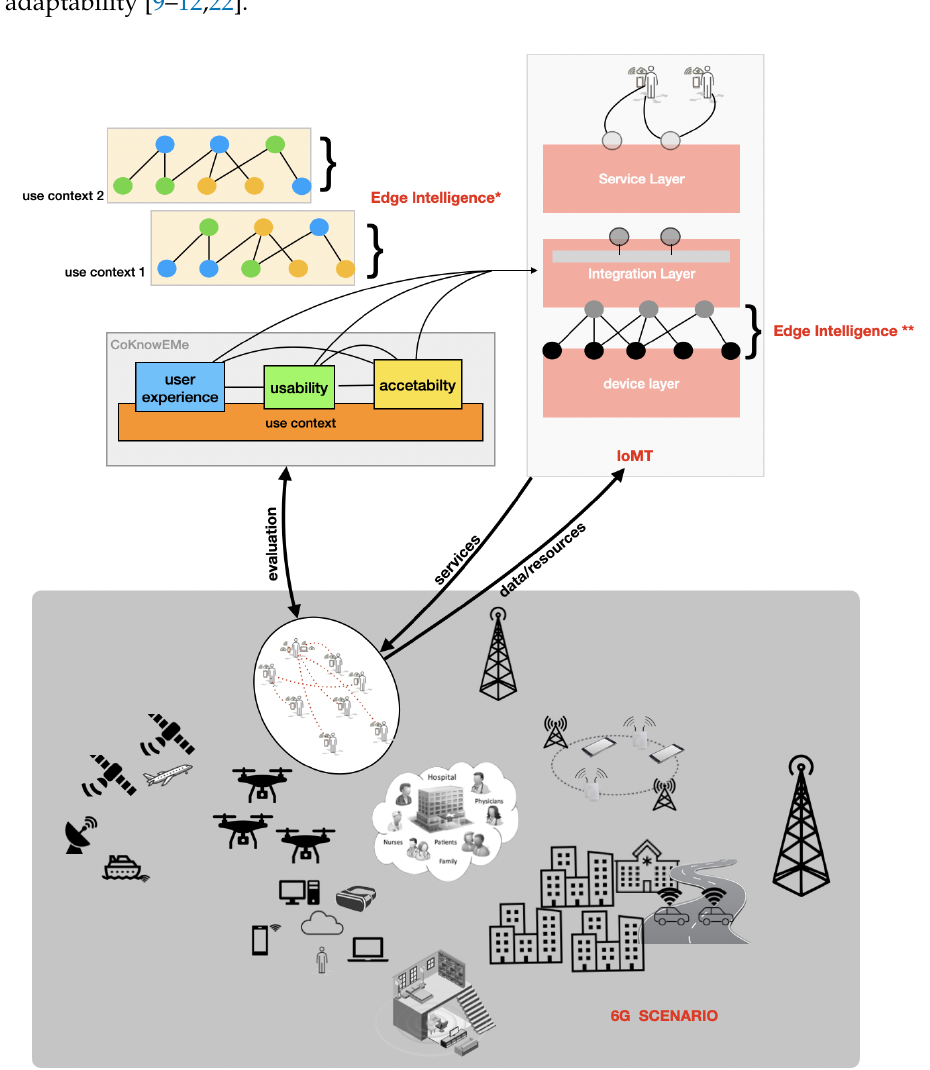
Figure 1. Evaluation in a 6G scenario for IoMT microservices. This figure shows the schematic representation of the evaluation scheme following the complex approach for IoMT services as dy- namical resources organized at the edge level in a multilevel architecture of IoMT systems. The edge intelligence level is intended as a complex evolutionary strategical approach for the distributed resources’ organization, both in terms of evaluation modules (*) and of IoMT integration layer